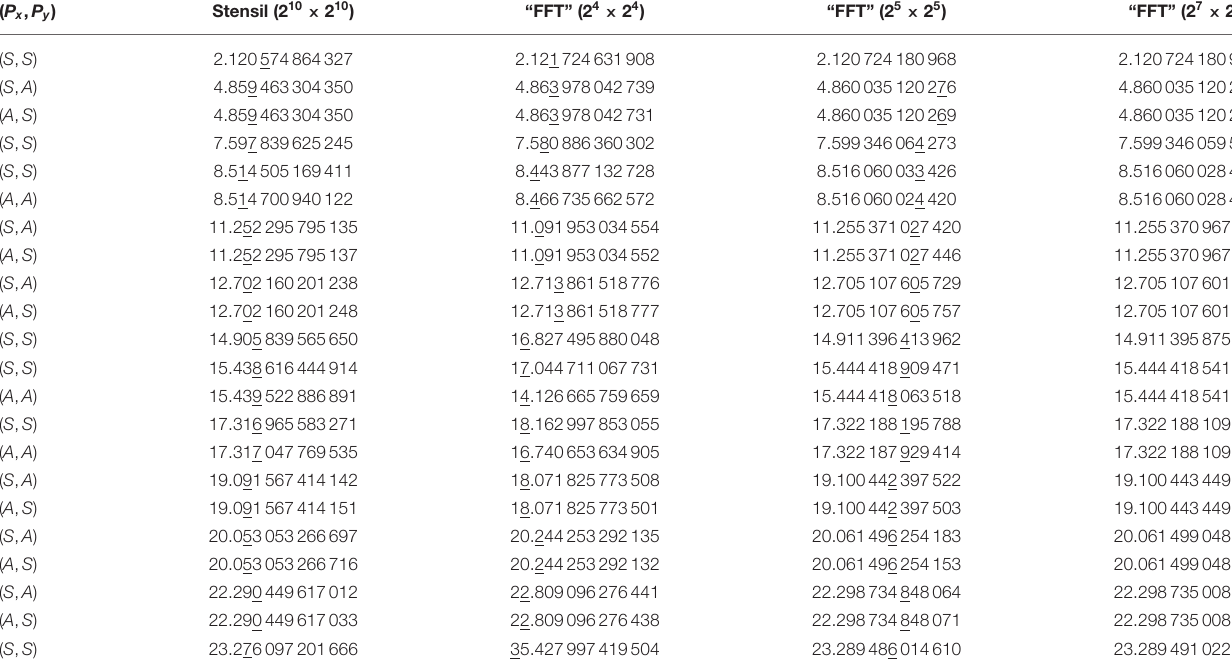
TABLE 4 | Numerical calculations of the lowest eigenvalues of the two-dimensional quantum anharmonic oscillator, by various approximations and lattice